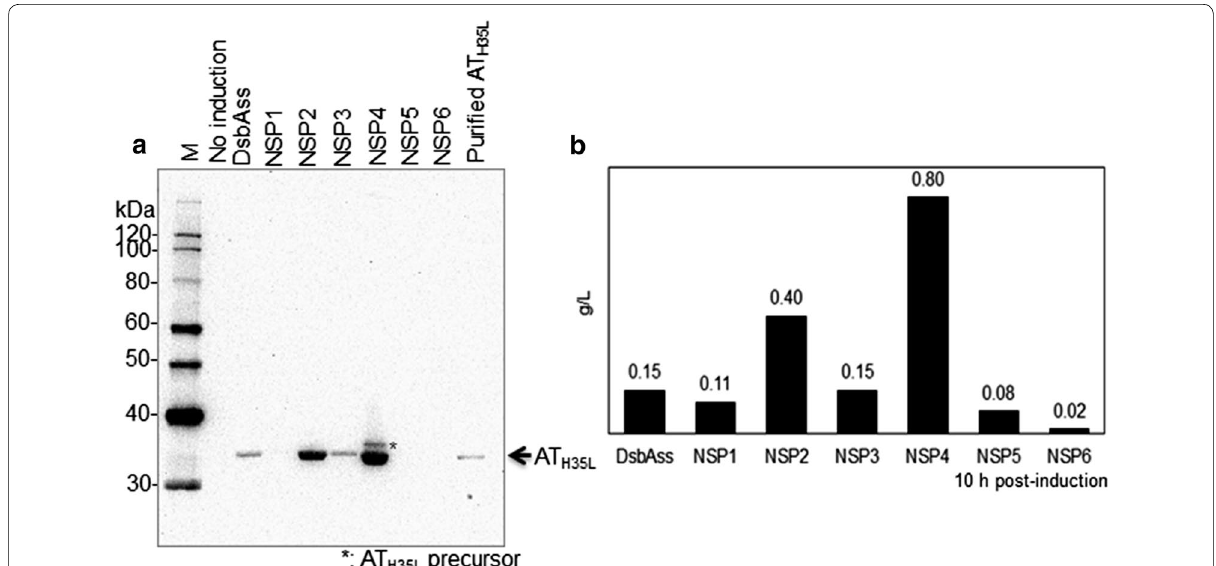
Fig. 3 Western blot and titer analyses of secreted AT H35L by Set I novel signal peptides in cell culture medium in 1L fed-batch bioreactor. a Western blot analysis of the secreted AT H35L protein. Arrow indicates secreted AT H35L protein and asterisk indicates leaked AT H35L precursor from dead cells. b Quantification of AT H35L protein in cell culture medium at 10 h